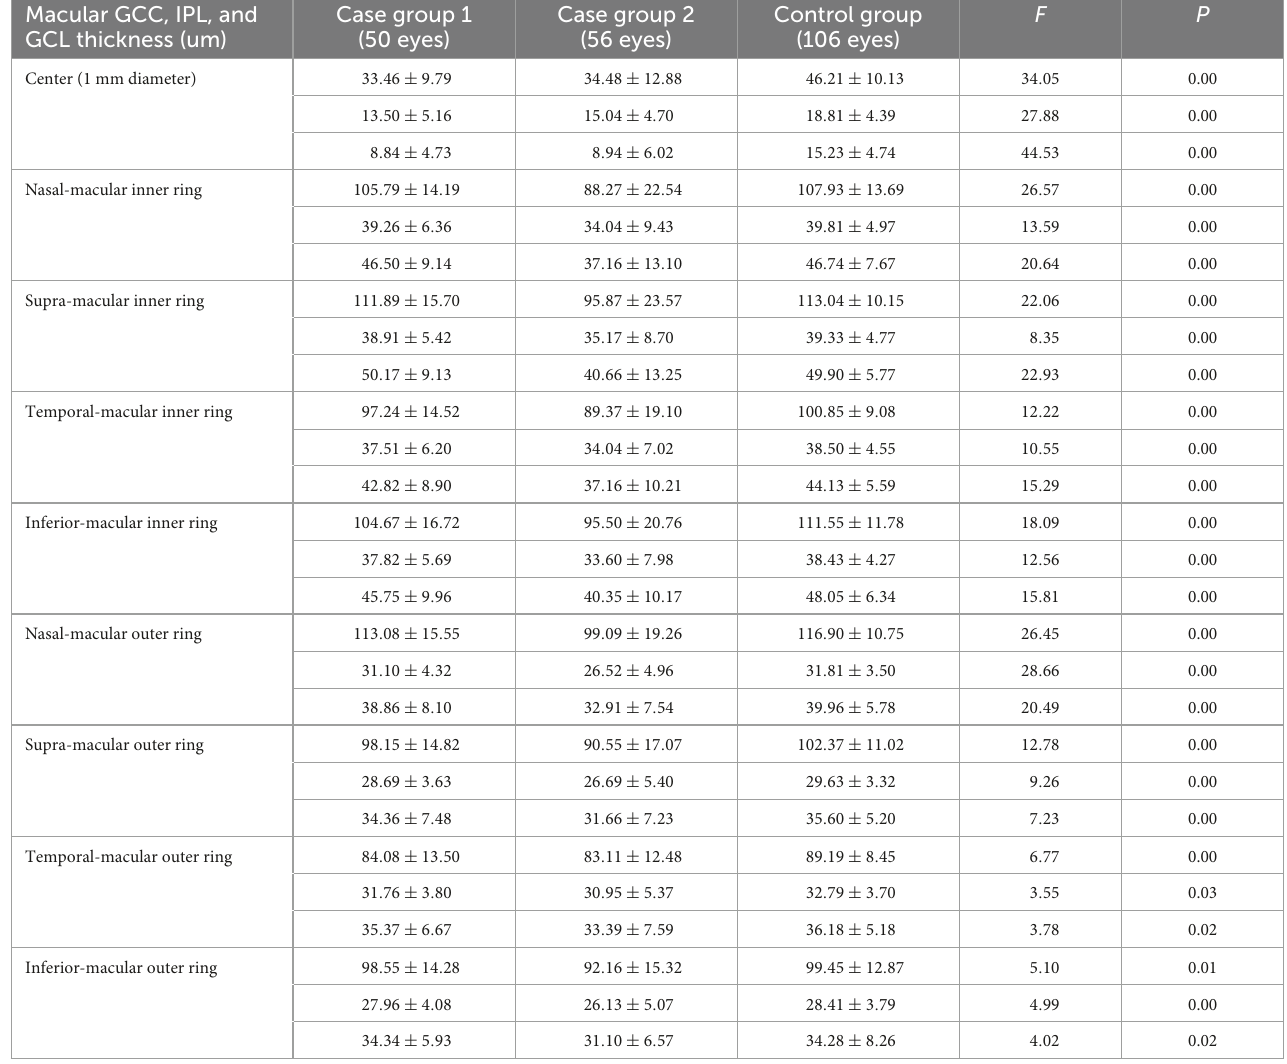
A comparison of case group 2 with the control group showed that the FA values of the optic nerve, optic chiasma, optic tract, and optic radiation in case group 2 decreased significantly ( P = 0.00, 0.00, 0.00, and 0.03), while the ADC values of the optic nerve, optic chiasma, and optic radiation increased significantly ( P = 0.00, 0.00, and 0.00) ( Table 4 ). There was no statistical difference in the ADC values of the optic tracts in group 1 and group 2 compared to the control group ( P = 0.55 and